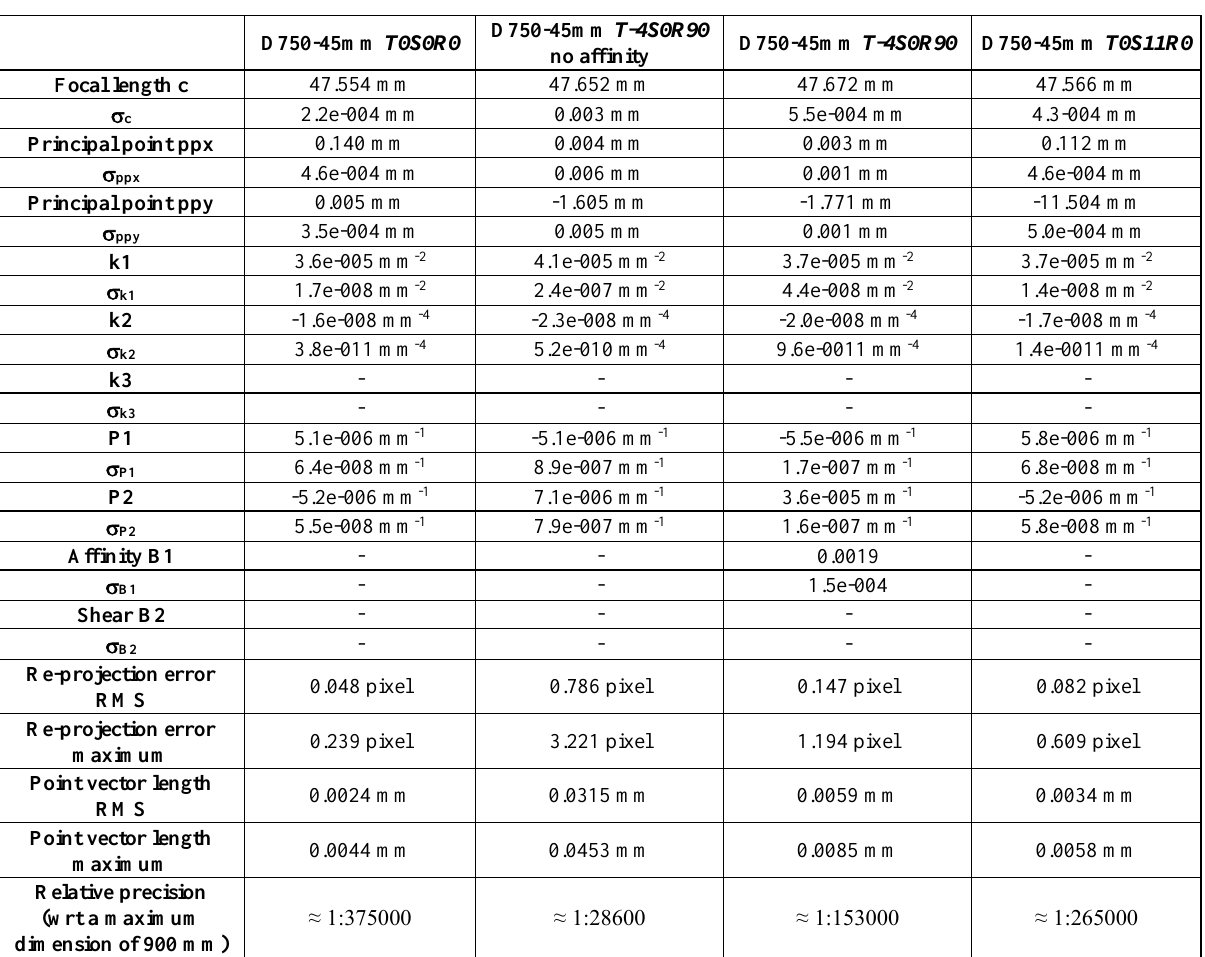
Table 3. Results of self-calibrating bundle adjustment for the tested photogrammetric systems. Interior orientation and additional parameters are reported along with internal assessment in image and object space.